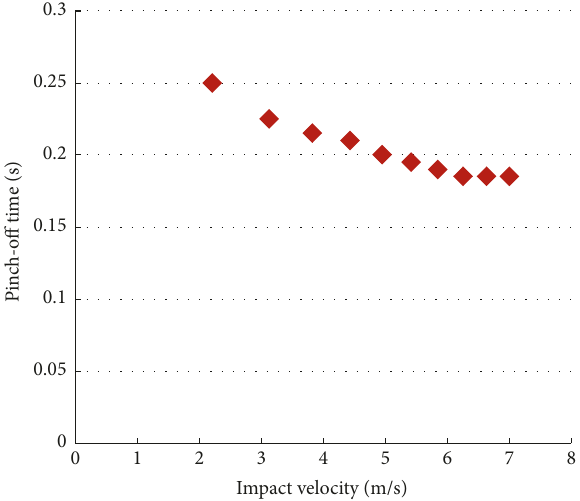
Figure 17: Pinch-off time versus impact velocity of conical pounder.